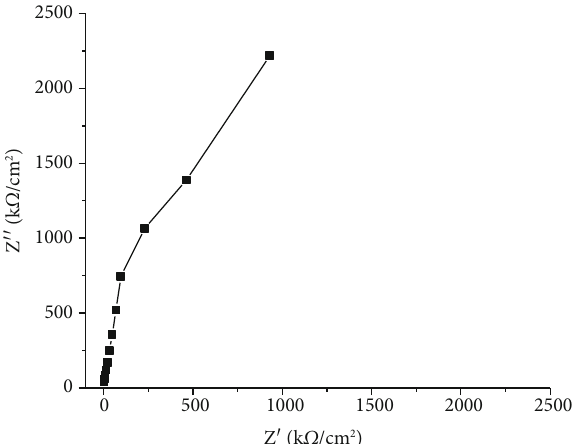
Figure 12: Nyquist diagrams for the device with dielectric paper.